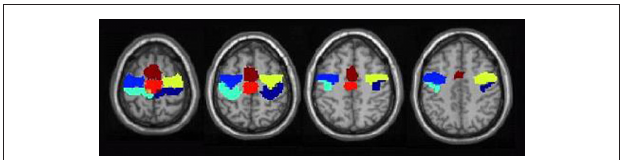
Figure 2 | regions of interest for premotor cortex drawn based on Picard and Strick’s (2001) functional distinction. Shown are the ROIs drawn on the MNI-152 T1 template for right (dark blue) and left (light blue) PMd, right (yellow) and left (blue) pre-PMd, SMA proper (red) and pre-SMA